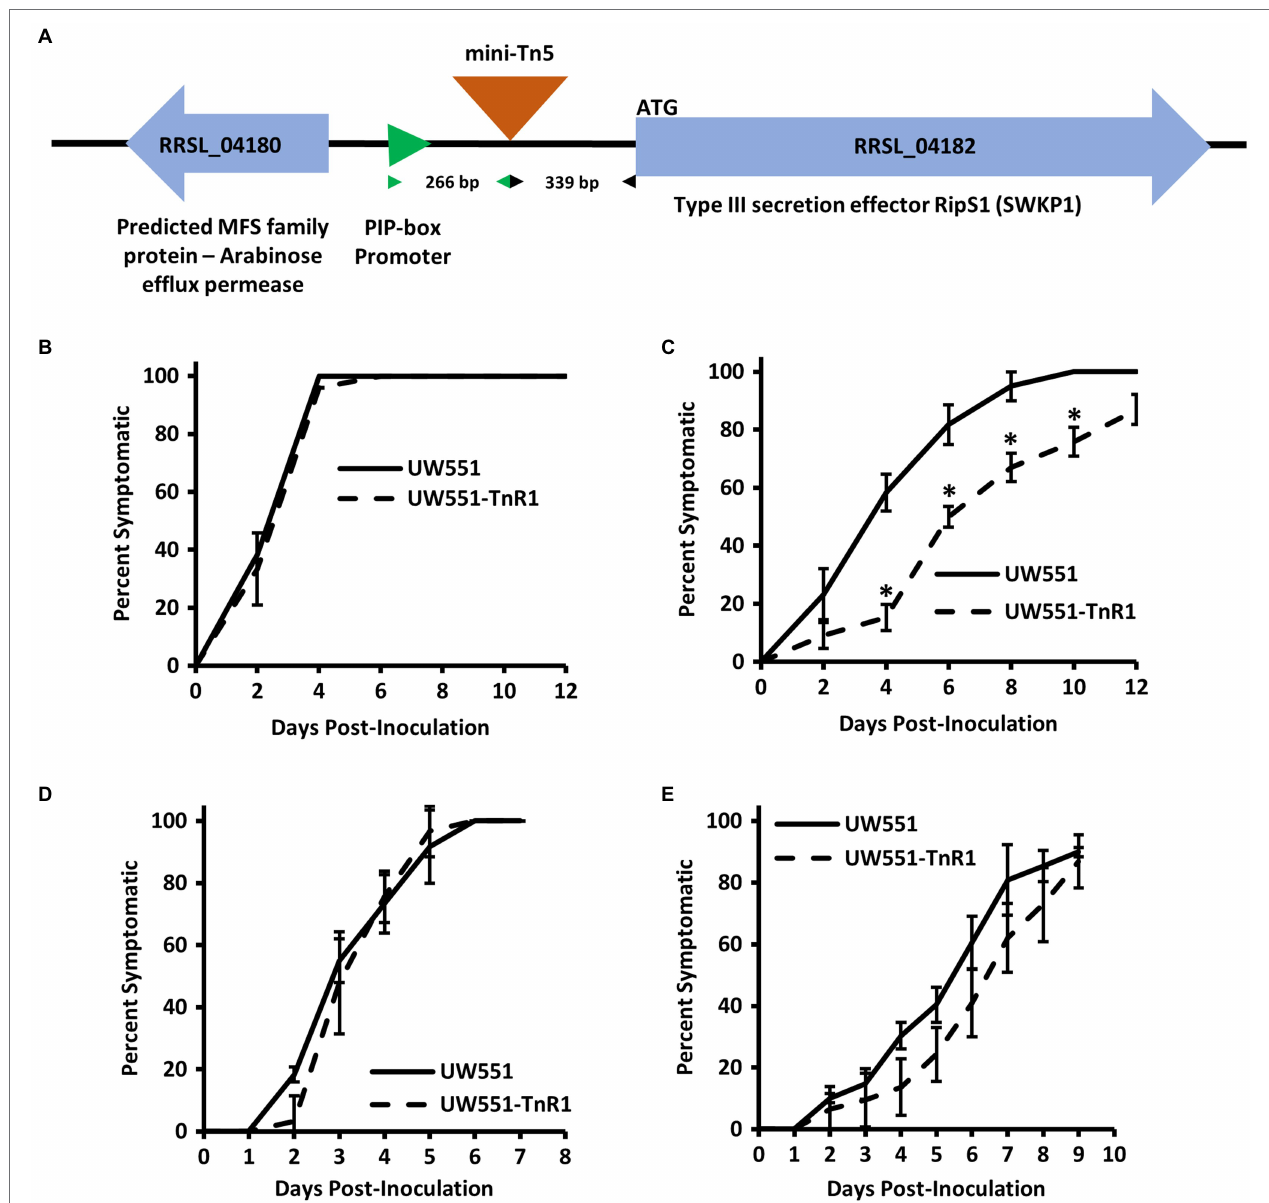
FIGURE 1 | Intergenic transposon insertion in mutant strain UW551-TnR1 reduces virulence at 20 ° C in tomato seedlings, but not when the mutant was introduced directly to the xylem. Schematic diagram showing the insertion site of the mini-Tn5 transposon in UW551-TnR1 between the major facilitator superfamily (MFS) protein gene RRSL_04180 and ripS1 in parental UW551, as well as the distance between the transposon insertion and associated plant-inducible-promoter (PIP) element and ripS1 , respectively (A) . Confirmation that mutant UW551-TnR1 recovered from Nicotiana glutinosa seedling screen exhibits full virulence at 28 ° C (B) and reduced virulence at 20 ° C (C) in tomato seedlings. No significant difference in virulence was observed between wild-type UW551 and mutant UW551-TnR1 at individual time points when each bacterium was inoculated directly to tomato xylem through a wounded petiole regardless of whether grown at 28 (D) or 20 ° C (E) . Experiments were repeated four times, each time with at least five seedlings across two wells of a 12-well plate (B,C) or five seedlings grown in soil (D,E) . Each individual seedling was assessed for any symptoms, including wilt, water soaking of leaves, collapse of stem, or brown discolored lesions on stem, and those showing symptoms were calculated as percent of all seedlings in that treatment group. Values show average of all four experiments and error bars represent SE. Asterisks denote statistically significant difference ( p < 0.05) from wild-type strain UW551 at the indicated timepoint by Student’s t